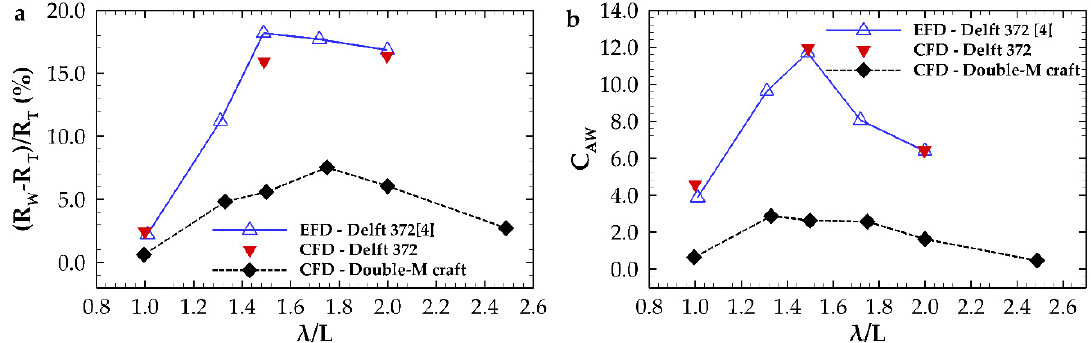
Figure 14. Comparison of the total resistance and the added resistance coefficients of the Delft 372 catamaran and Double-M craft with Fr = 0.7 in head sea waves: ( a ) Added resistance relative to calm water resistance, ( b ) Added resistance coef- ficient.